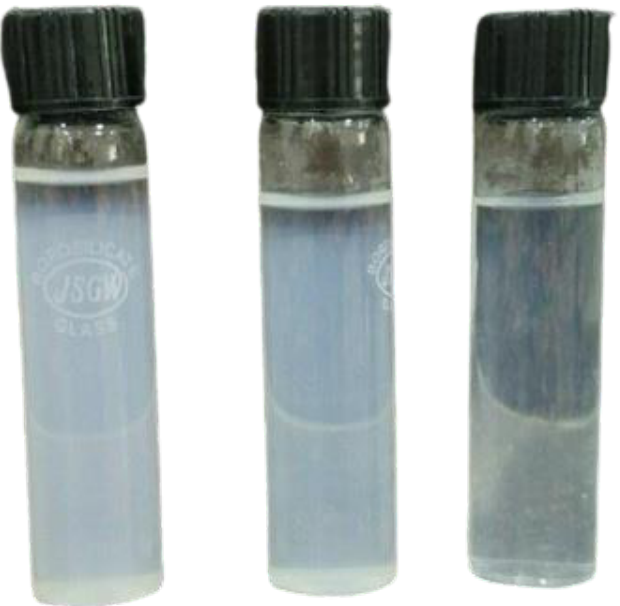
Figure 6. Visual representations of the nanofluids in the